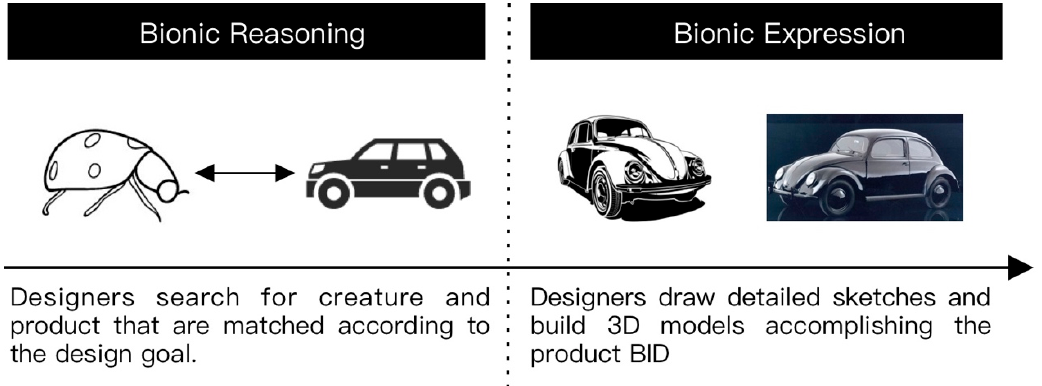
Figure 1. Product design process.